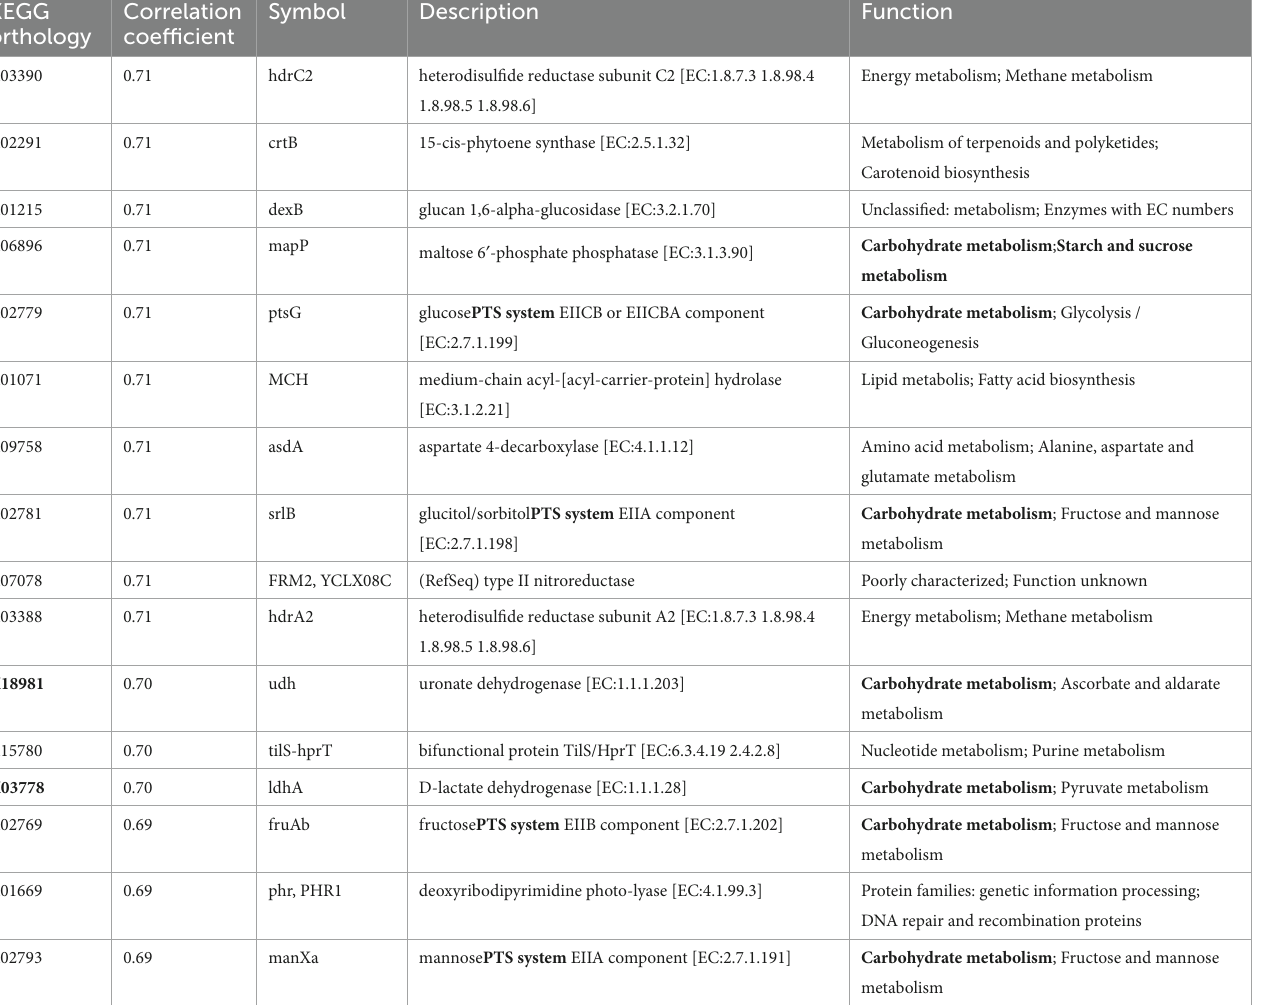
Bold letters in Description and Function exhibit referred with the results of BRRITO. Items exhibit bold letter in KEGG orthology are candidate enzymes directly related with extracellular electron transportation. K00198 and K11261: related to obligate anaerobes; K03778, K08325 and K18981: related to lactic acid bacteria; K00324 and K00325; related to facultative anaerobes.